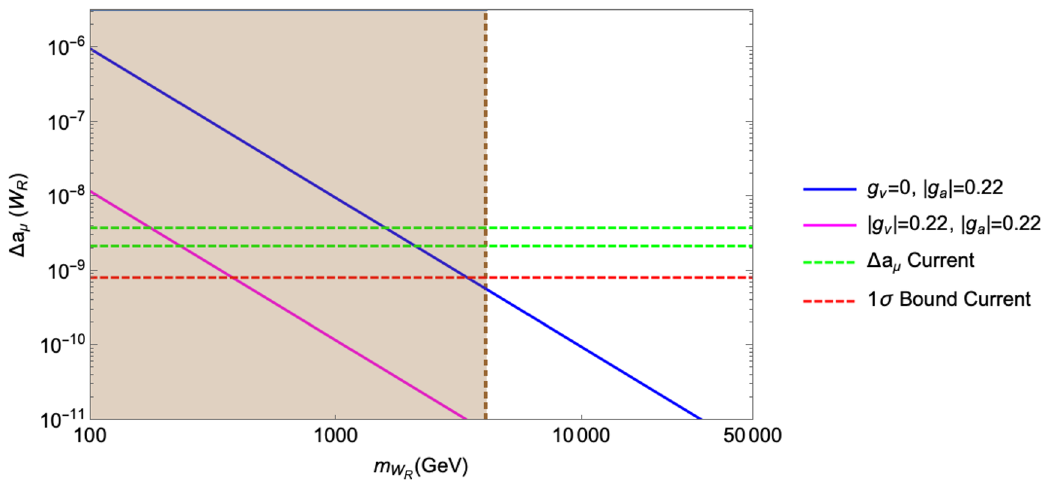
Figure 7 . Plot showing the contribution of charged vector boson W R to (cid:1) a (cid:22) for the case g L = g R . The blue line represents the contribution of W R when purely axial vector-like coupling is considered and magenta line represents the contribution when both vector-like and axial vector-like couplings are considered non-zero. It shows with purely axial vector-like coupling W R with mass 2 TeV can address the anomaly whereas the case with combination of both couplings can satisfy the muon anomaly bound for m W 200 GeV. Brown shaded region indicates the excluded mass range of R (cid:24) W R from collider constraints. So both the muon anomaly contributions is ruled out from collider constraints on m W R